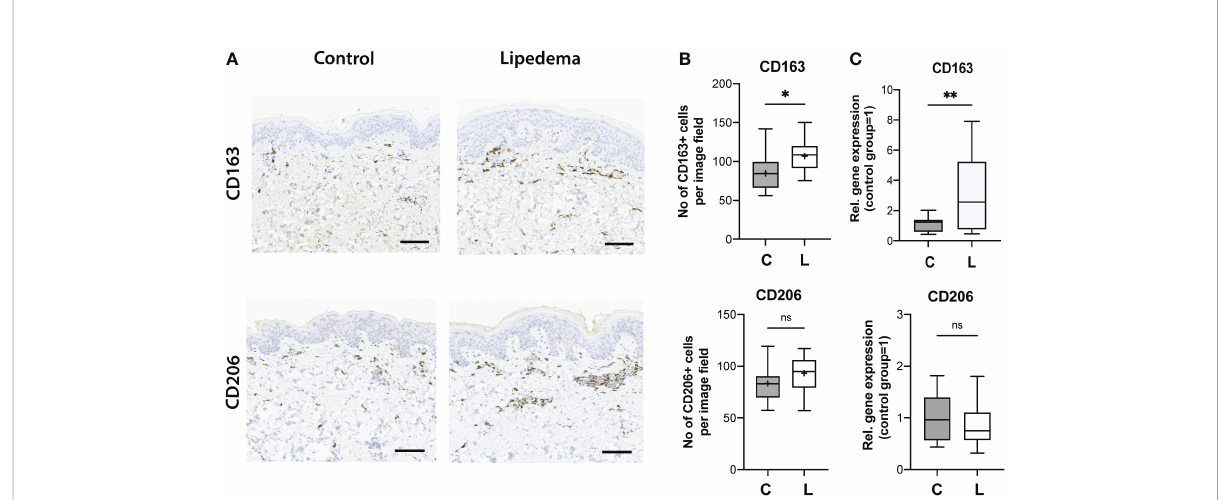
FIGURE 4 Increased CD163+ cell in fi ltration and expression levels in human skin in lipedema. (A) The immune cell in fi ltrate was evaluated on paraf fi n- embedded skin tissue sections. (B) Quanti fi cation of the CD163+ and CD206+ cells revealed increased in fi ltration of CD163 + cells in skin tissue. N(C): 14, N(L): 15 (C) The evaluation of the CD163 and CD206 expression in fat tissue. N(C): 14, N(L): 15 patients. Scale bar: 100 m m. Asterisks indicate statistical signi fi cance in comparison to the control *P < 0.05, **P < 0.01 (two-tailed Student ’ s t-test). ns, not signi fi